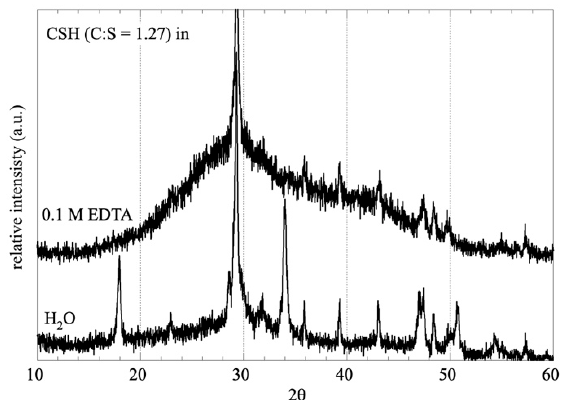
Figure 1. X-ray diffractograms of a C-S-H solid phase in contact with 0.1 M EDTA solution and de-ionized water.